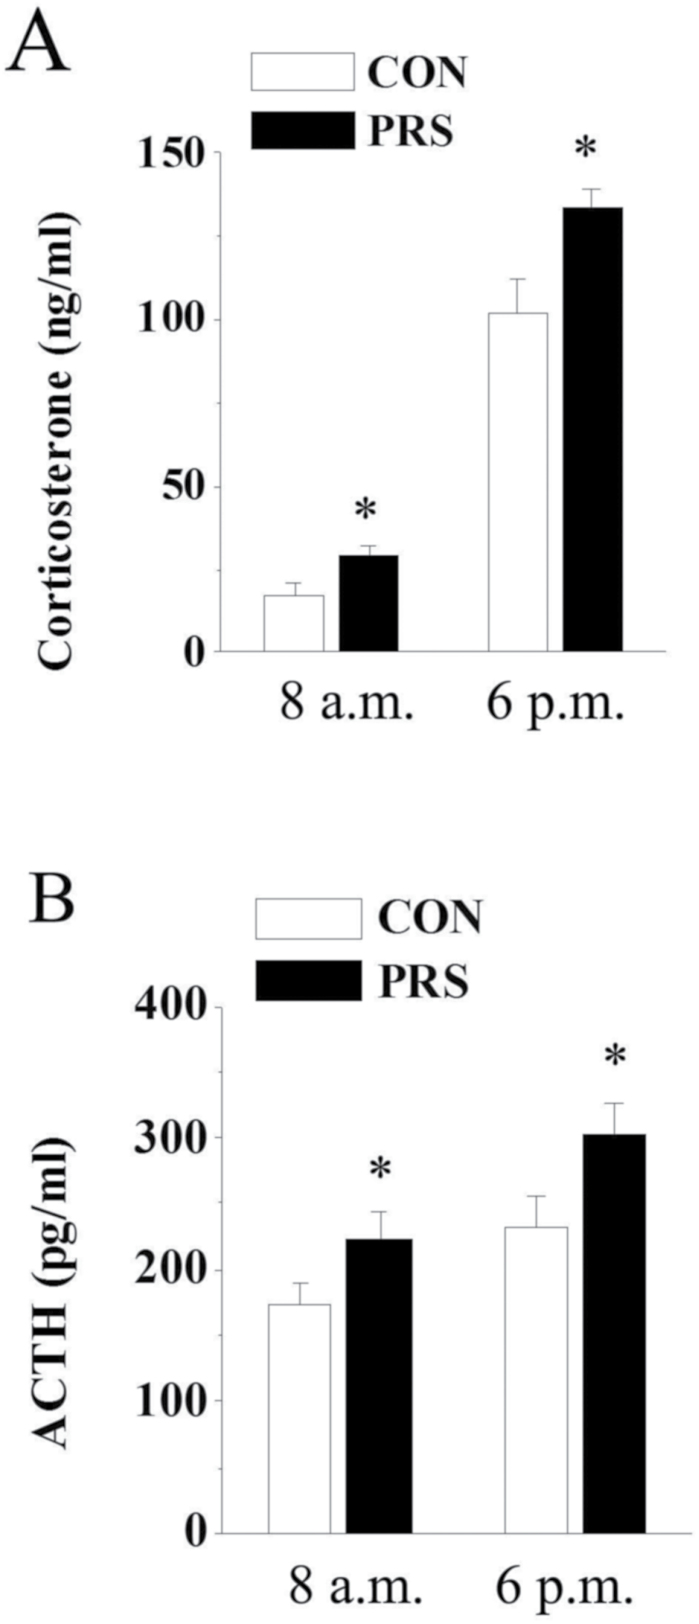
The basal activity of hypothalamo-pituitary-adrenal (HPA)-axis is potentiated in prenatal stress (PRS) mice. CON and PRS represent control and PRS mice, respectively. (A and B) PRS mice showed a significant increase in basal corticosterone (A) and adrenocorticotropin (ACTH) (B) concentrations. Sample collection was performed in the morning (8:00 am) and in the afternoon (6:00 pm). All bars represent means±SEM; 2-tailed Student’s t test; *P<.05 between the data of control (n=10) and PRS mice (n=12) at the same time.